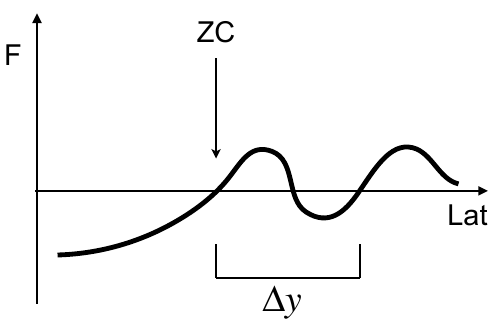
Figure 1. A depiction of the latitude of the zero crossing ZC of some field F along the interval lat . The distance to the nearest zero crossing with the same sign change is denoted by (cid:49)y